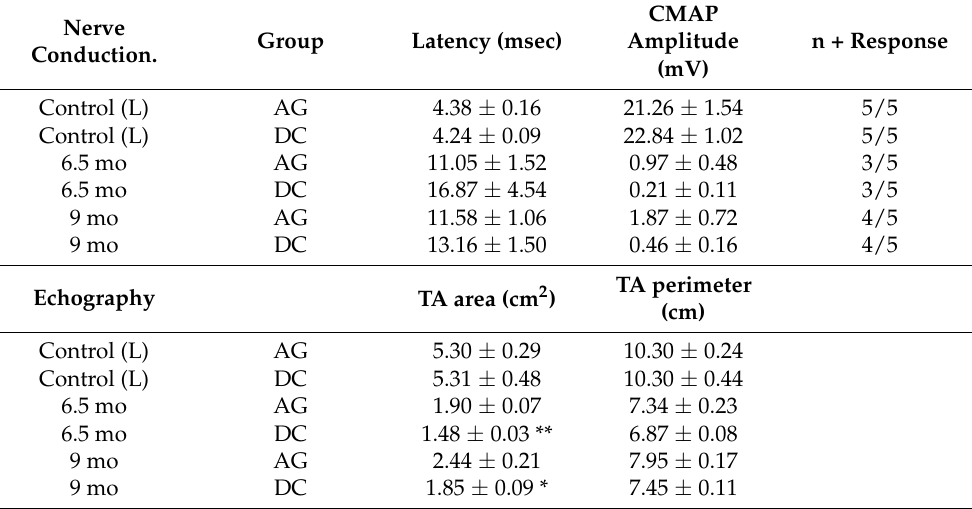
Table 1. Values of the nerve conduction tests in the peroneal nerve and of the echography tests in the peroneal innervated muscles, in the control left limb and in the operated right limb ( n = 5 each) at 6.5 and 9 months postoperation. * p < 0.05 vs. AG; ** p < 0.01 vs. AG. Results were analyzed by unpaired t test using GraphPad Prism 8